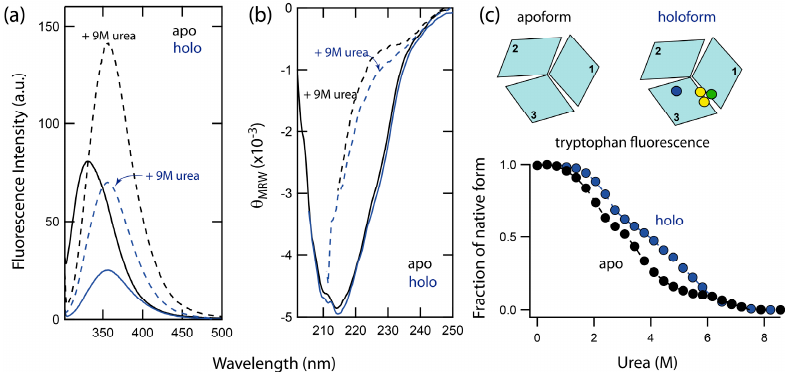
Figure 1. ( a ) Fluorescence of holo (blue lines) and apo (black lines) forms of Fet3p in buffer (solid line) and in the presence of 9 M urea (dashed line). ( b ) Corresponding far-UV CD spectra of holo and apo forms of Fet3p. ( c ) Isothermal urea-induced unfolding of holo (blue circles) and apo Fet3p variants (black circles) probed by Trp fluorescence (ratio F 331nm /F 355nm ). The circles, in schematically shown structures, indicate locations of T1 (blue), T2 (green), and binuclear T3 (yellow) copper ions. Protein (~5 μ M) was measured in 50 mM TrisHCl, pH 7.4 and given urea concentration at 23 °C.